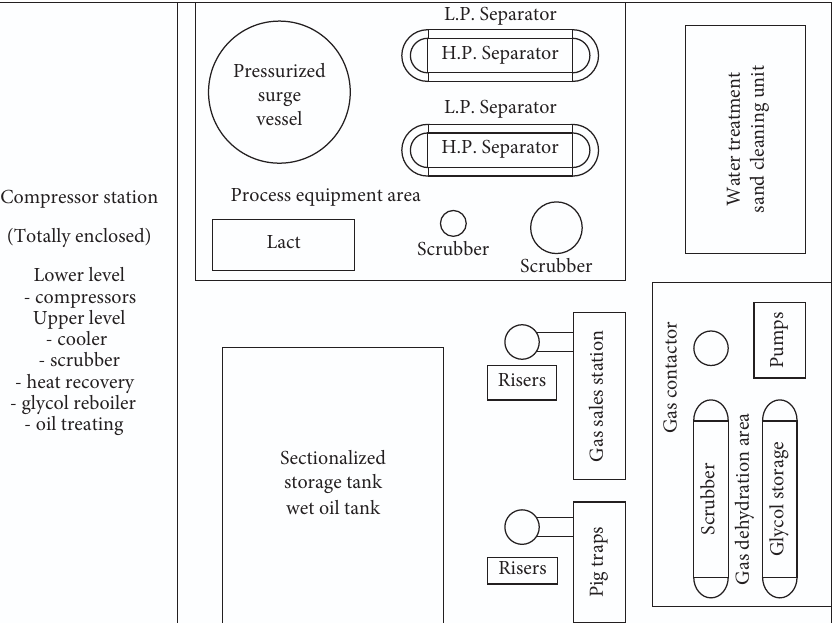
Figure 3: Basic layout information of example